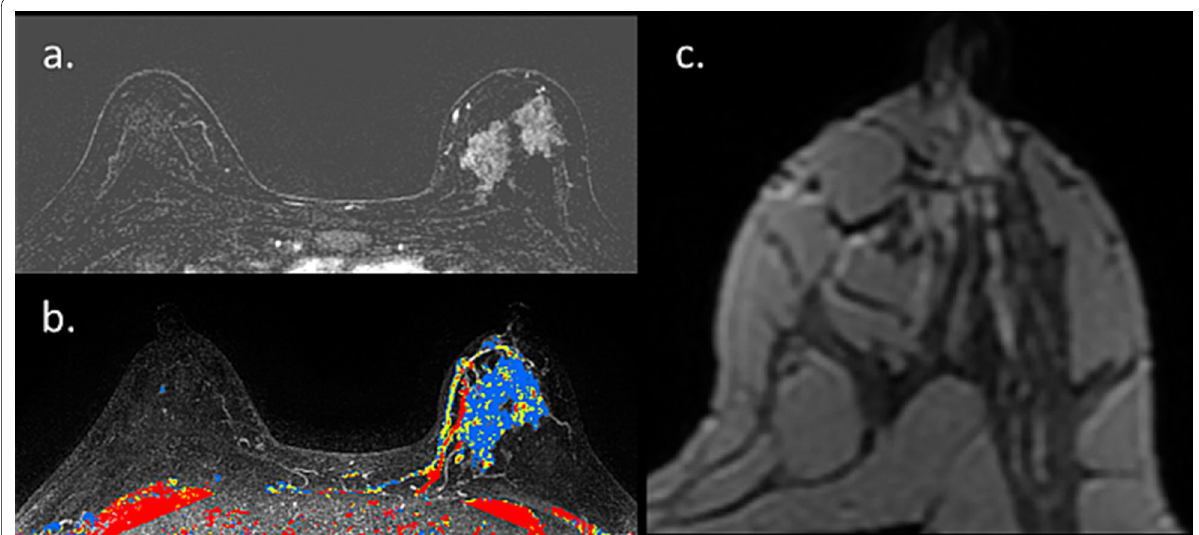
Fig. 20 MRI of breast cancer diagnosed post‑weaning. Pre‑operative MR images of 42‑year‑old patient with DCIS, newly diagnosed to months after cessation of breastfeeding are presented. Subtraction DCE ( a ) and CAD ( b ) reveal large nonmass enhancing lesion in the left breast, on top of minimal BPE. Non‑fat surpassed T2‑weighted image at the height of the nipple reveal high signal ducts in the sub‑areolar region ( c ), representing the transformation of the breast from lactation to involution